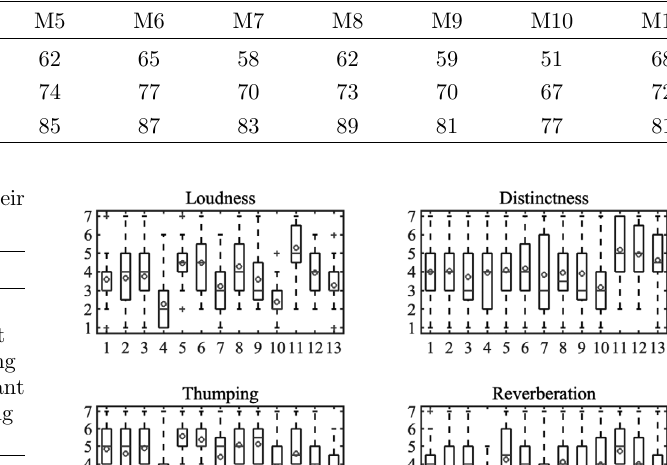
Table 2. Weighted standardized impact sound pressure levels and correction terms in dB.